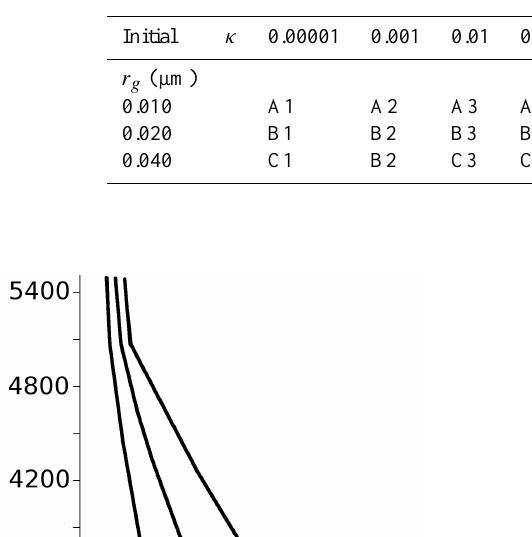
Table 3. RAMS sensitivity simulation names and initial values for r g and κ .